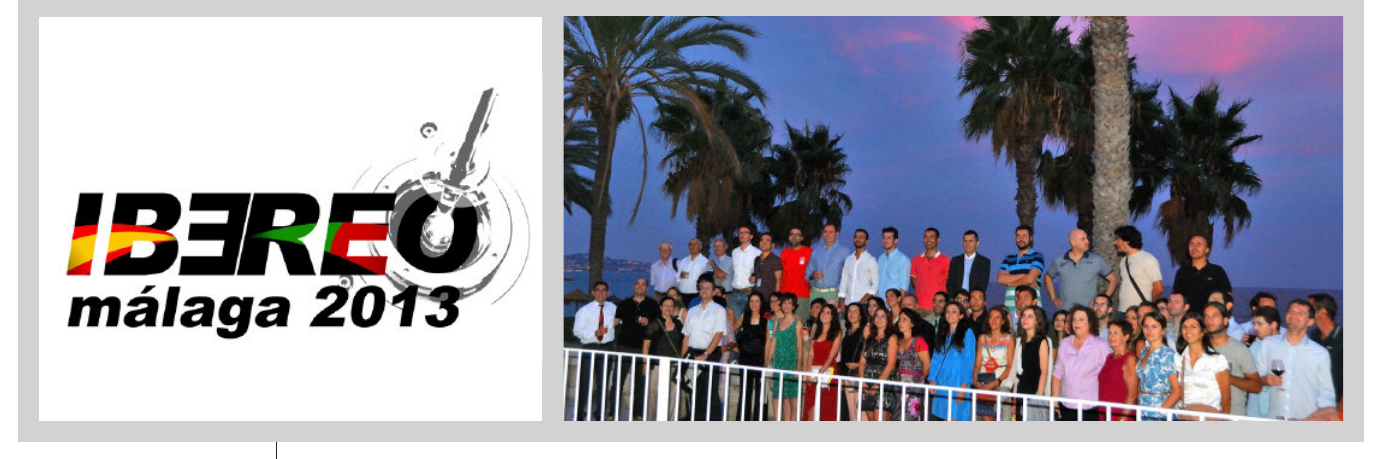
Figure 1 (left): Ibereo2013 logo. Figure 2: Participants at the IBEREO2013 on the promenade in